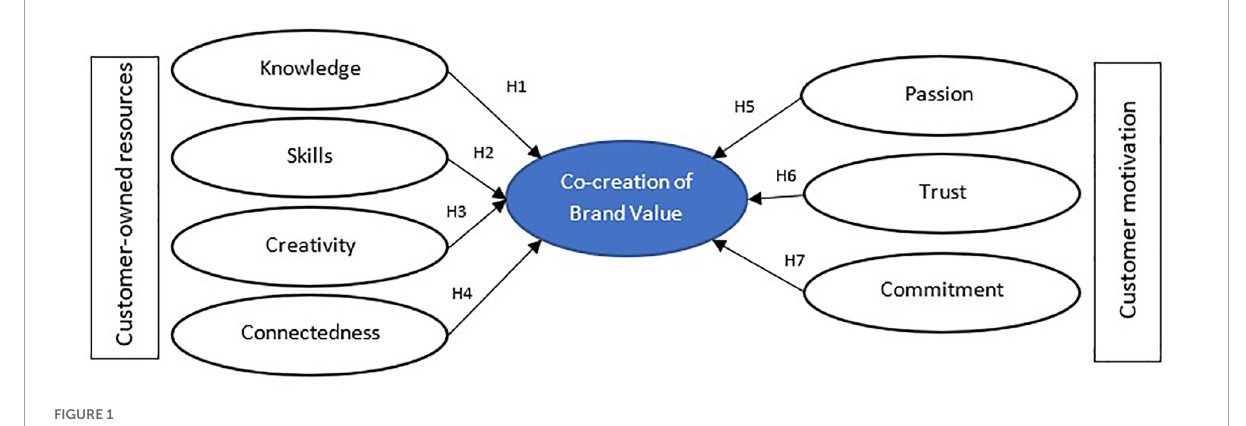
FIGURE1 Research